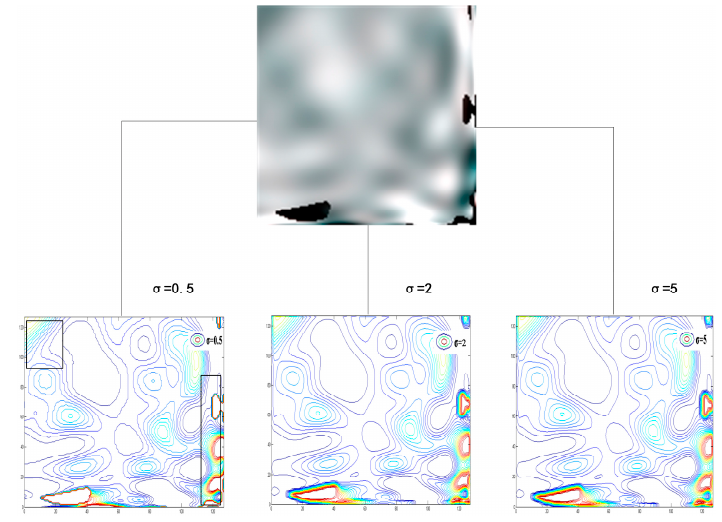
Figure 9. Data fields corresponding to different impact factors.